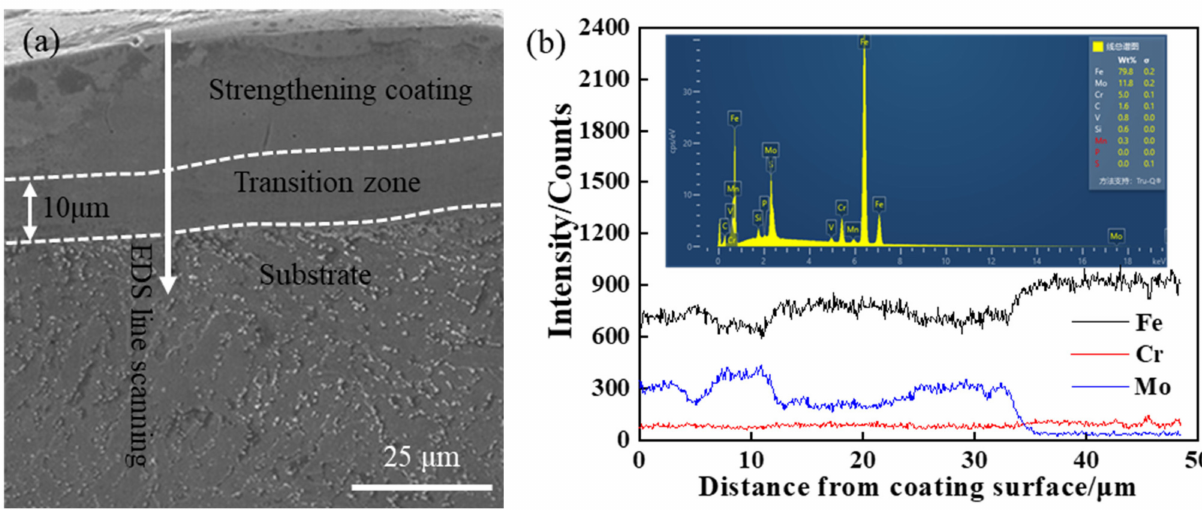
Figure 14. Morphology cross-section and elements distribution of coating fabricated under 1000 W/350 Hz/(3 min/cm 2 ): ( a ) the cross-section of coating and ( b ) line scanning results of elements distribution.